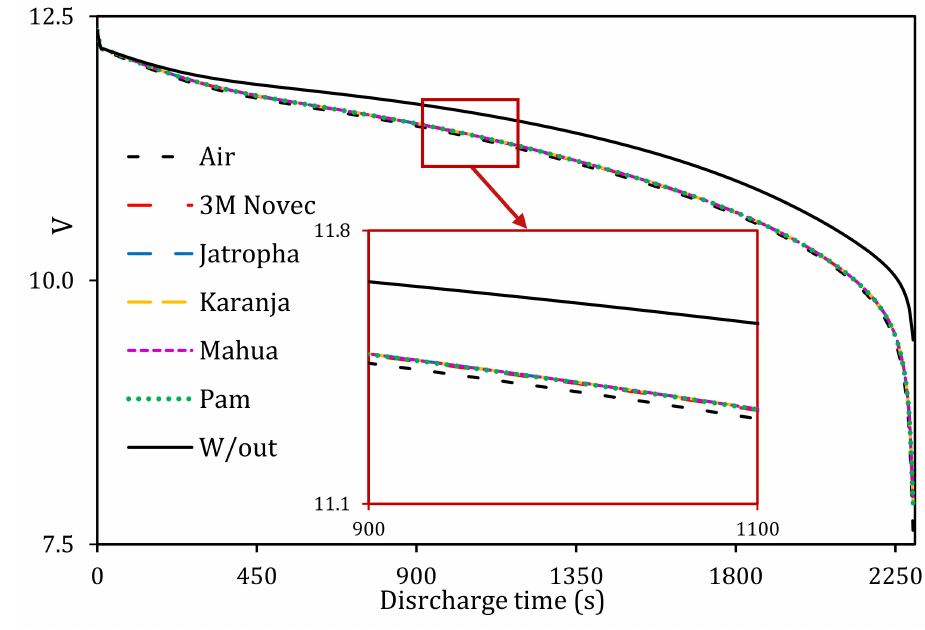
Figure 15. LIB module voltage versus discharge time for all BTMS coolants at 3C.